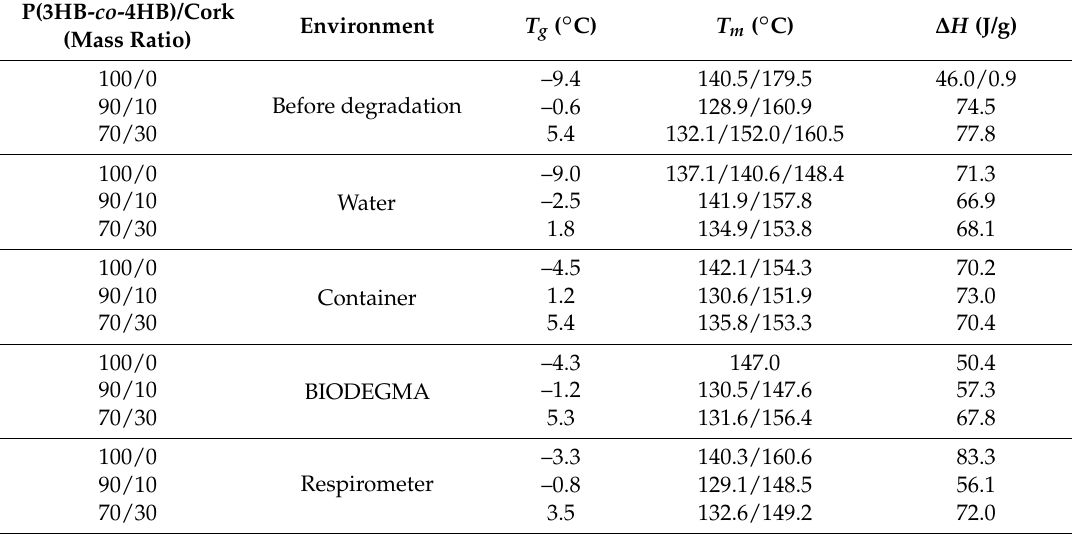
Table 4. Calorimetric parameters of P(3HB- co -4HB) and P(3HB- co -4HB)/cork composites before and after 21 days of degradation in different